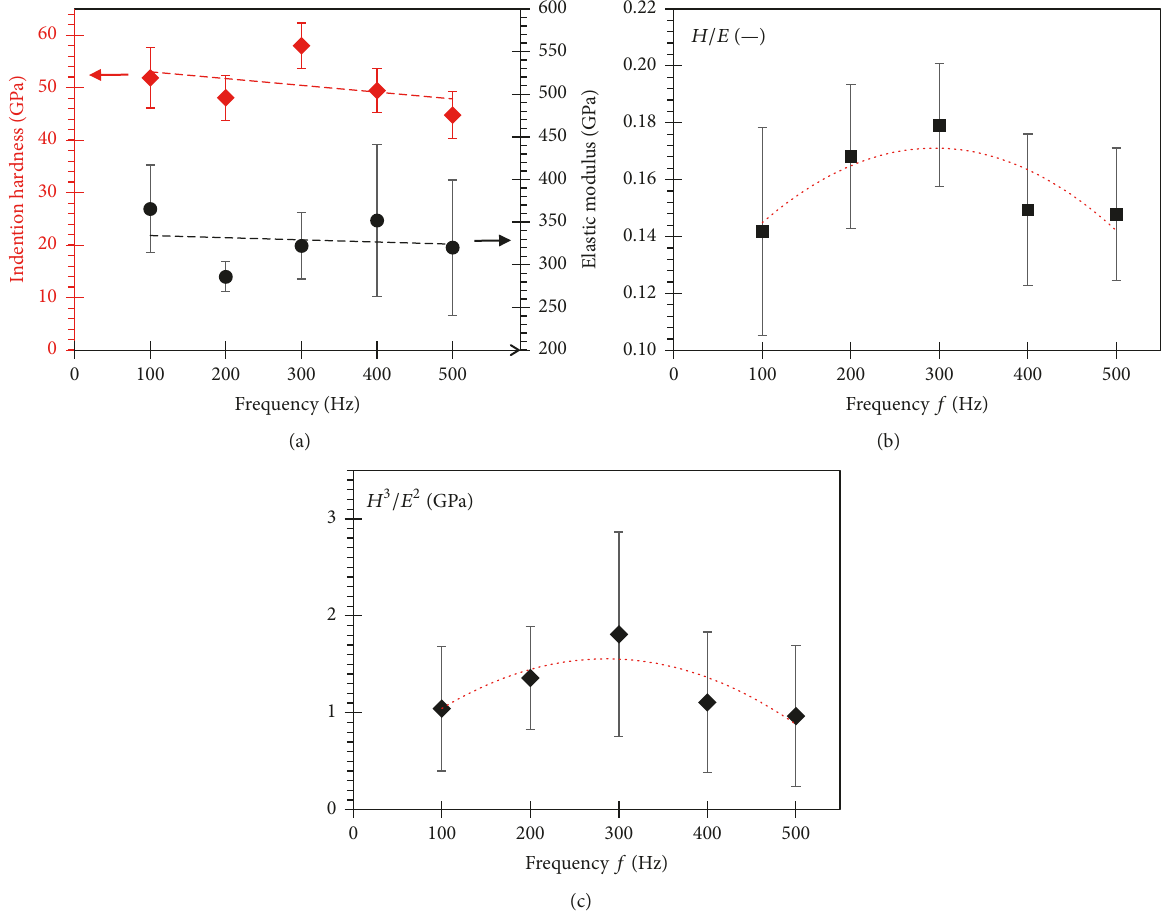
Figure 12: Mean indention hardness and elastic modulus with standard variance in GPa (a), calculated resistance against elastic deformation (elastic strain to failure) (b), and plastic deformation (c) of AlTiN coatings deposited by HPPMS with various pulse-frequency in the range of 100–500 Hz at cathode mean power of 4kW, pressure of 0.6 Pa, and deposition temperature of 500 ∘